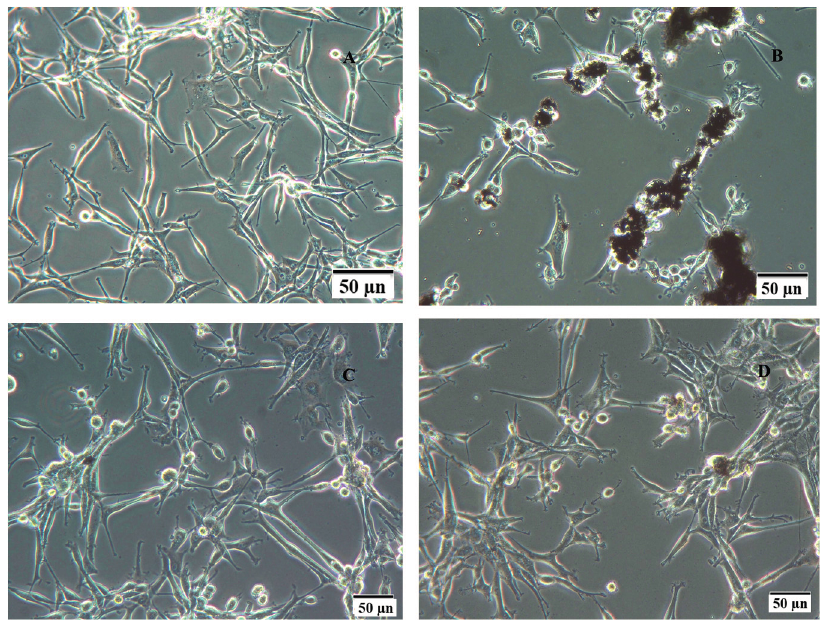
Figure 6. Morphology of U-87 glioblastoma cells in the control group ( A ) and after treatment with reduced graphene oxide ( B ), reduced graphene oxide with arginine ( C ), and reduced graphene oxide with proline ( D ). Notes: Reduced graphene oxide flakes formed agglomerates ( B ), all graphene forms adhered to the cells.